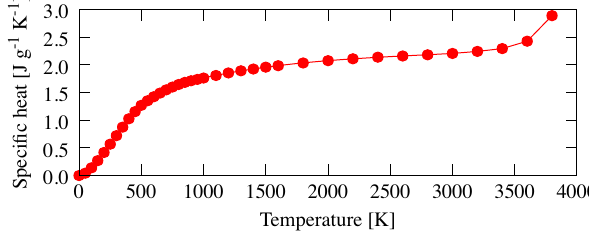
FIG. 15. Specific heat at constant pressure of graphite Steine- mann R4550 as a function of